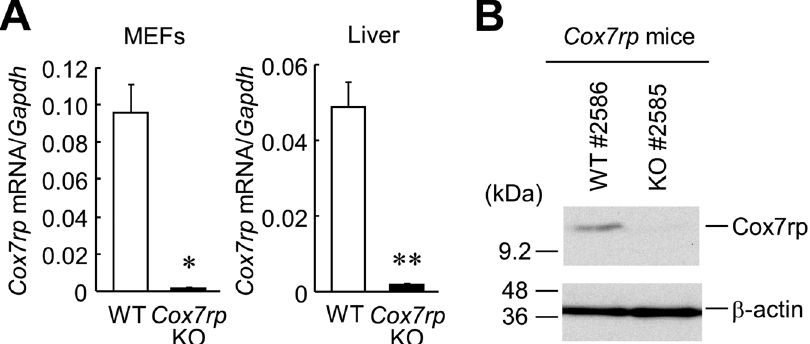
Figure 1. Depletion of Cox7rp expression in liver of Cox7rp KO mouse. ( A ) Expression level of Cox7rp mRNA was quantified by qRT-PCR in MEFs and liver. Data are presented as means ± SEM ( n = 3). * P < 0.05, ** P < 0.01, using Student’s t test. ( B ) Western blot analysis of Cox7rp protein expression in liver. Cytosolic fraction was prepared from Cox7rp KO and WT livers and subjected to western blot analysis using COX7RP antibody and β -actin antibody for loading control. Unprocessed original scans of the blots are shown in Supplementary Fig.